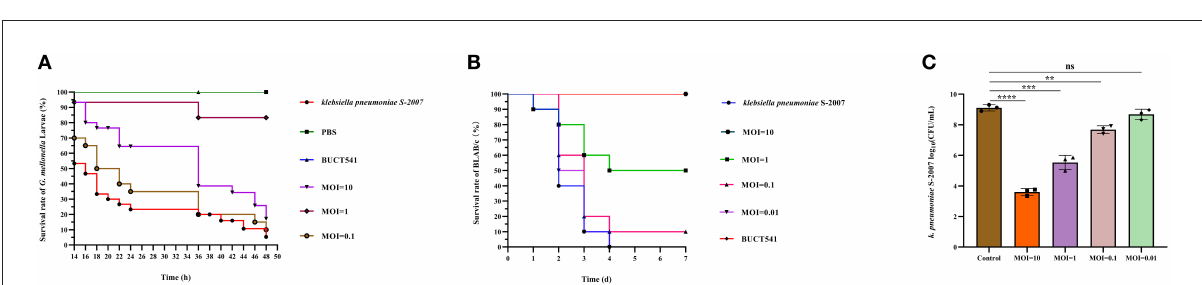
FIGURE7 Evaluation of the effect of phage BUCT541 against K. pneumoniae S-2007 in vivo . (A) Survival curves of G. mellonella larvae after treatment with phage BUCT541 at different MOIs or PBS. (B) Survival curves of mice treated with phage BUCT541 at different MOIs or PBS. (C) The amount of K. pneumoniae S-2007 in the lungs of mice after 30h treatment with different MOIs phage BUC541. Data are shown as the mean ± SD, **** P < 0.0001, *** P < 0.001, and ** P < 0.01, indicate a significant difference compared to the control group.